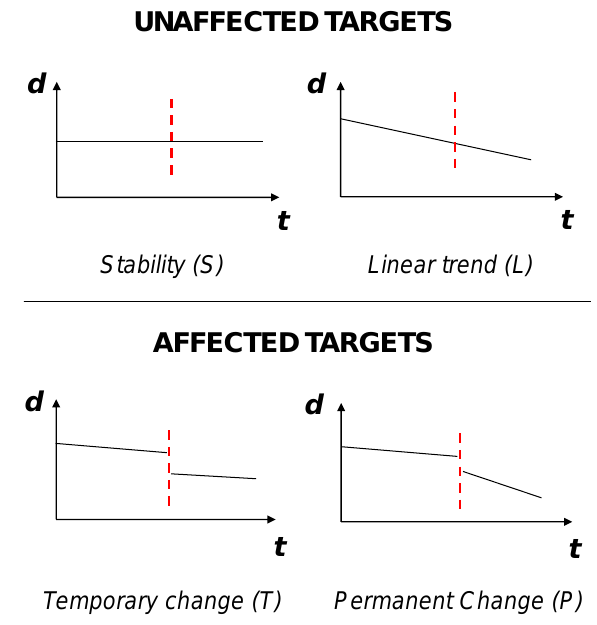
Fig. 2. Classification of PSI time series with respect to a deformational event (red dashed line). Two different deformational behaviours ( d , displacements; t , time) are identified: unaffected targets (classes S and L) and affected targets (classes T and